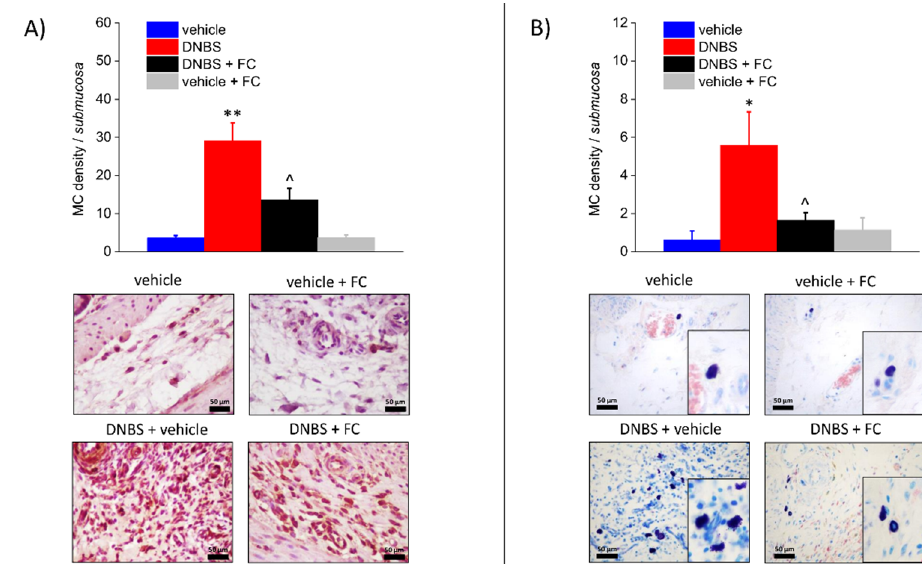
Figure 3. Effect of systemic fluorocitrate administration on submucosal MCs increase induced by DNBS. The panel shows pictures captured from submucosa of MCs stained with antibody to tryptase ( A ) or with GIEMSA ( B ). Column graphs display the mean values of MC density per area of colonic wall (cells/field) ± S.E.M. obtained from 6 animals for each group. * p < 0.05 and ** p < 0.01 vs. vehicle. ^ p < 0.05 vs. DNBS. Original magnification: 40×. Scale bar: 50 μ m.